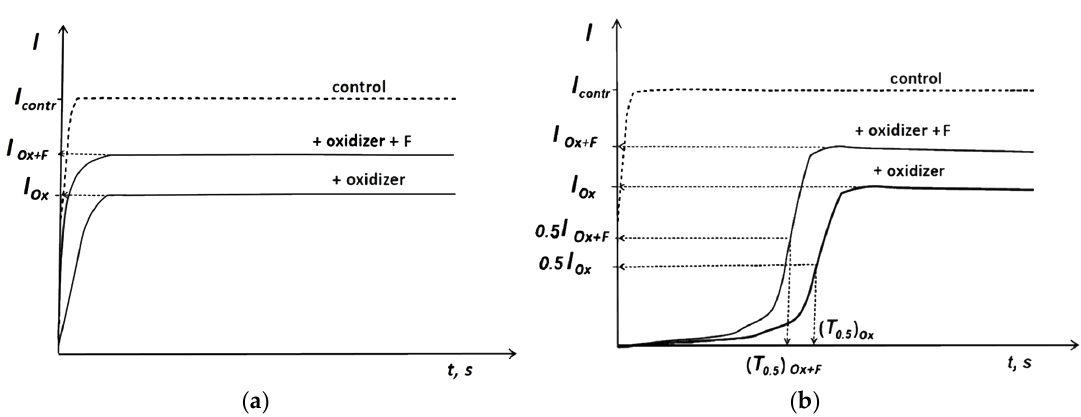
Figure 7. Bioluminescence kinetics in the solution of model oxidizer 1,4-benzoquinone (Ox) and fullerenol (F): ( a ) cellular assay and ( b ) enzymatic assay.